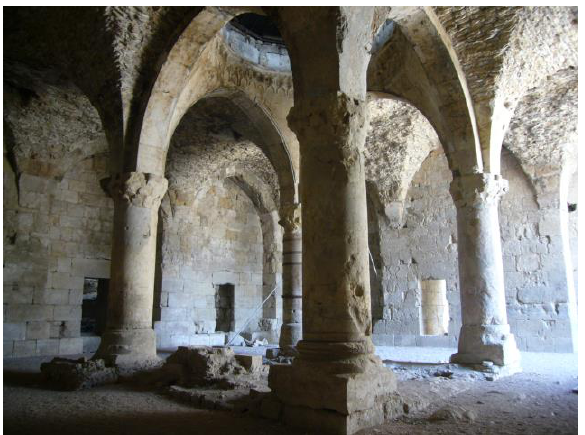
Figure 13. The great vaulted Ayyubidd Hall